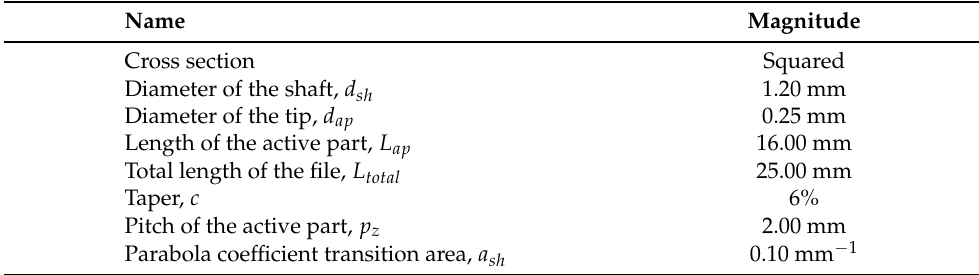
Table 1. Definition of cases of study.